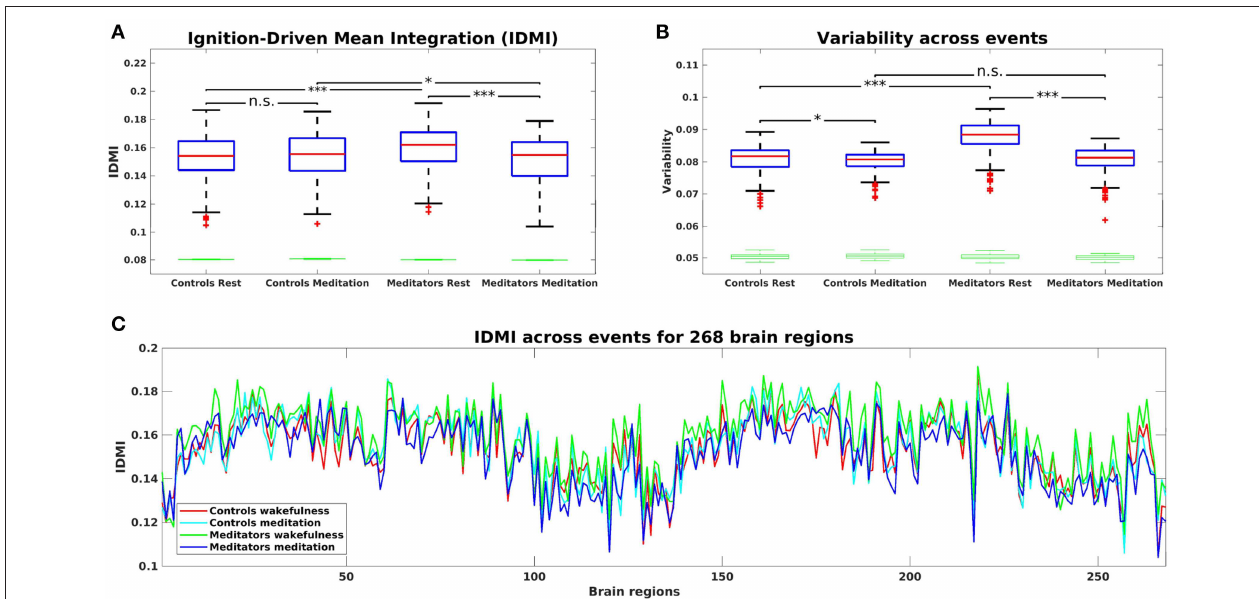
FIGURE 2 | (A) Mean of the Intrinsic-Driven Integration (IDMI) for each group during resting-state and meditation state. The IDMI was higher in meditators than in controls during resting-state and lower in meditators during meditation. No significant differences were observed in controls between conditions. Furthermore, we show the box plot from the surrogate IDMI data (on the bottom in green). The randomized data were significantly smaller than the original time-series, showing the robust statistical comparisons. (B) Both controls and meditators showed higher local metastability across the whole-brain during resting-state compared to meditation. However, the effect was significantly larger for meditators. Furthermore, the metastability in resting-state was significantly higher for experienced meditators than for controls. P -values are based on Monte-Carlo simulation after Bonferroni correction, * p ≤ 0.025, *** p ≤ 0.0005 and n.s represents not significant. (C) IDMI across events for each group during resting-state and meditation for 268 brain